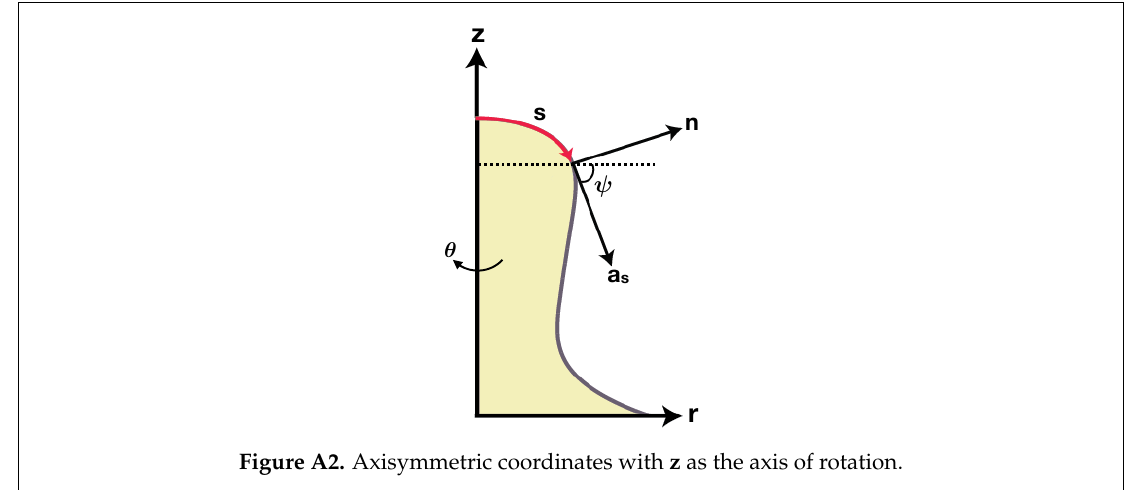
Figure A2. Axisymmetric coordinates with z as the axis of